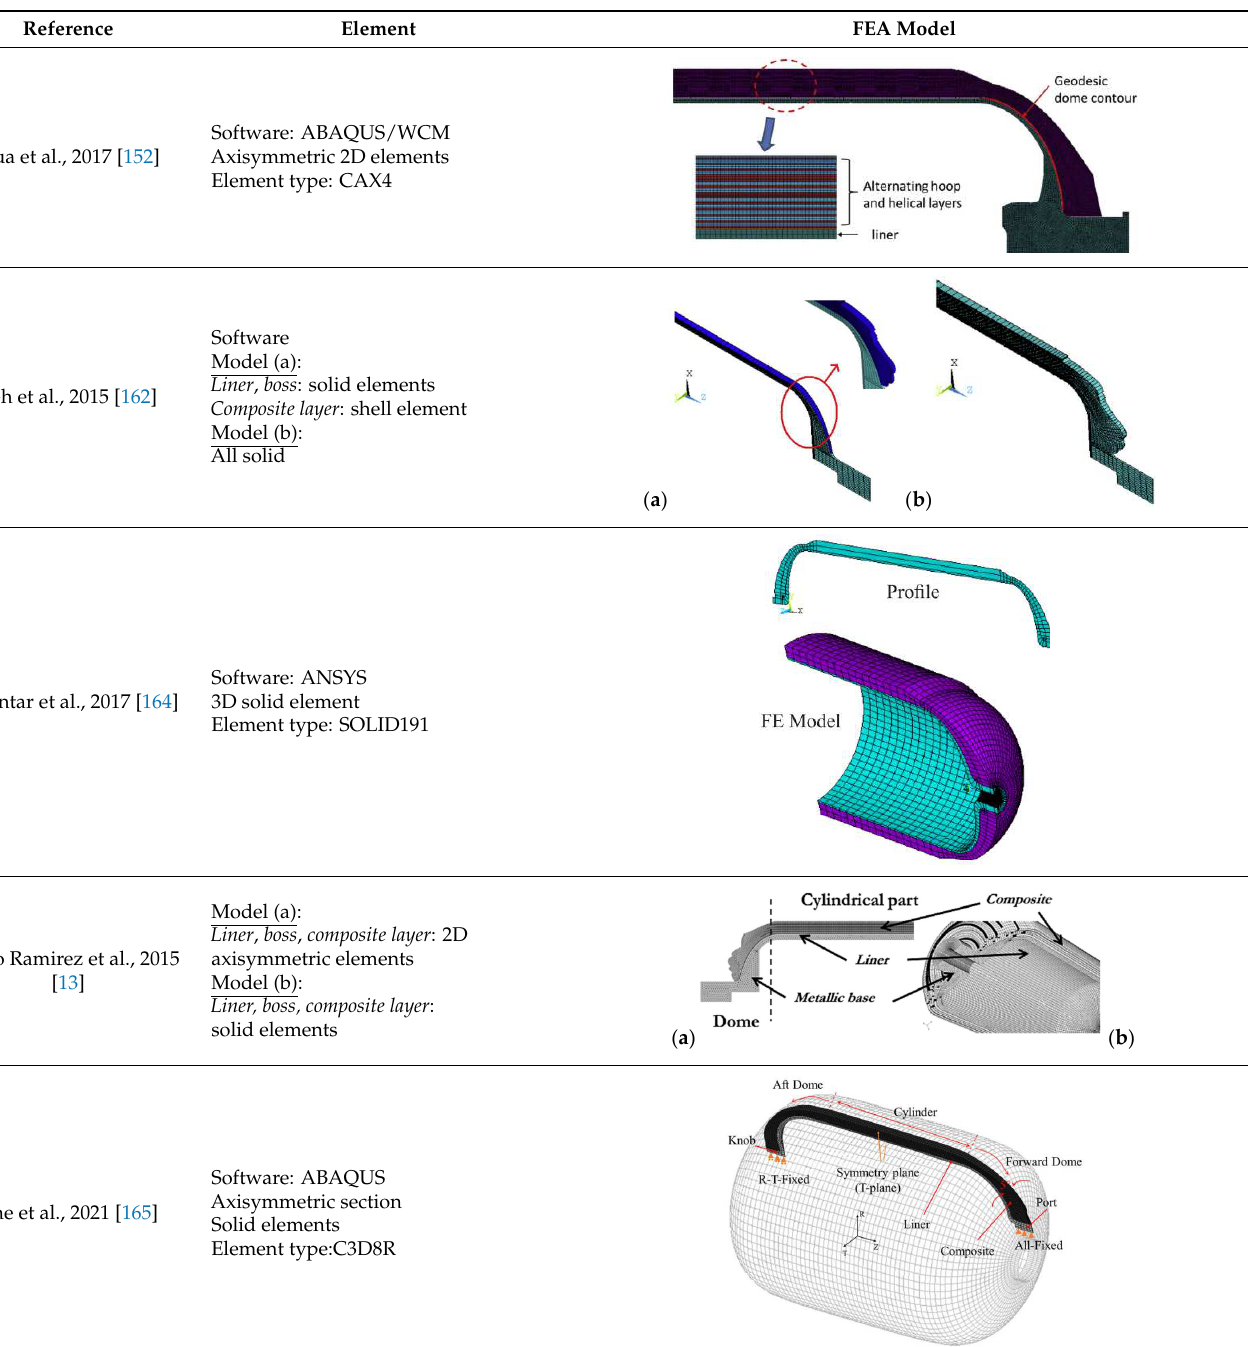
Table 6. Summary of numerical studies for investigation of mechanical response of composite